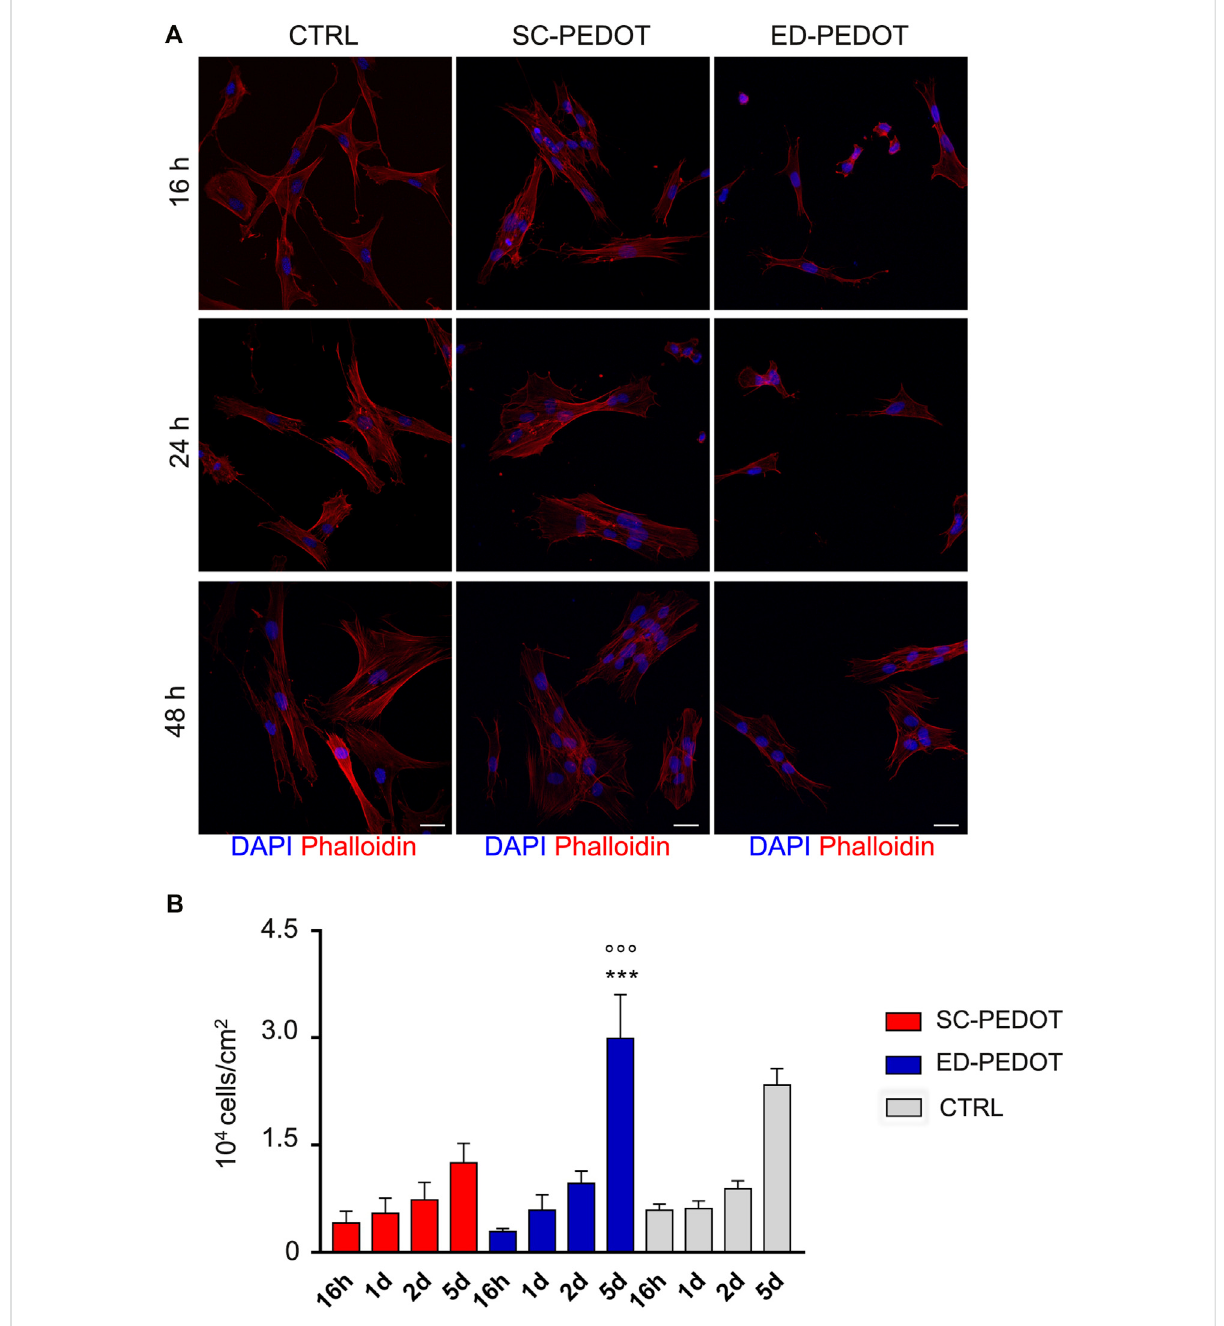
Evaluation of cell morphology, adhesion and proliferation of neural crest-derived stem cells on PEDOT:PSS fi lms. (A) Immuno fl uorescence images showing cell morphology and adhesion of phalloidin-stained hDPSCs (red) grown on PEDOT:PSS fi lms at different time points (16, 24 and 48 h). Nuclei were counterstained with DAPI. hDPSCs cultured on plastic culture plates were taken as controls. Scale bar: 20 μ m. (B) Histograms represent cell proliferation of hDPSCs cultured on PEDOT:PSS fi lms (16 h, 1, 2 and 5 days). Cell countings are reported as mean ±